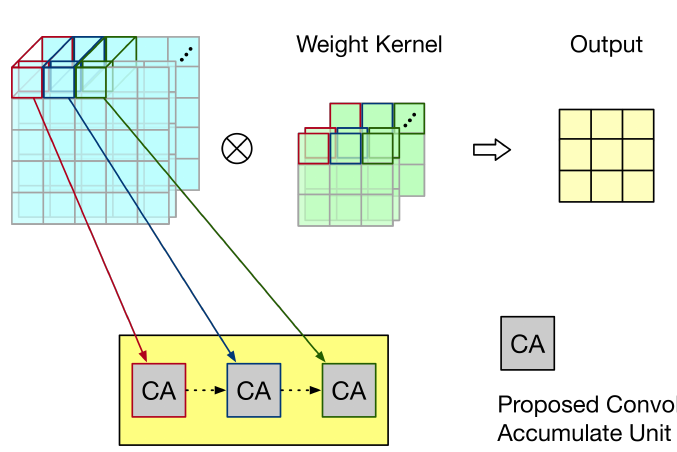
Figure 17. An illustration for output stationary